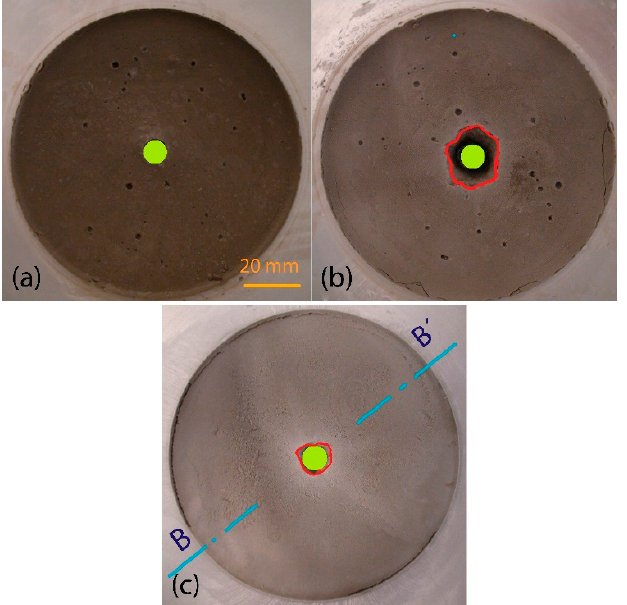
Figure 8. Inlet side of specimens with Bentonit 75: ( a ) grout mixture B1 before the test; ( b ) grout mixture B1 after the test—WL = 1.4%; ( c ) grout mixture B5 after the test—WL = 0.2% (the edge of the failure area in red, the initial hole in green).